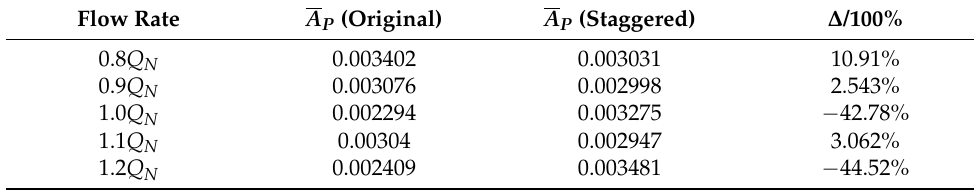
Table 4. Average values and variation values of 2f bpf amplitude.